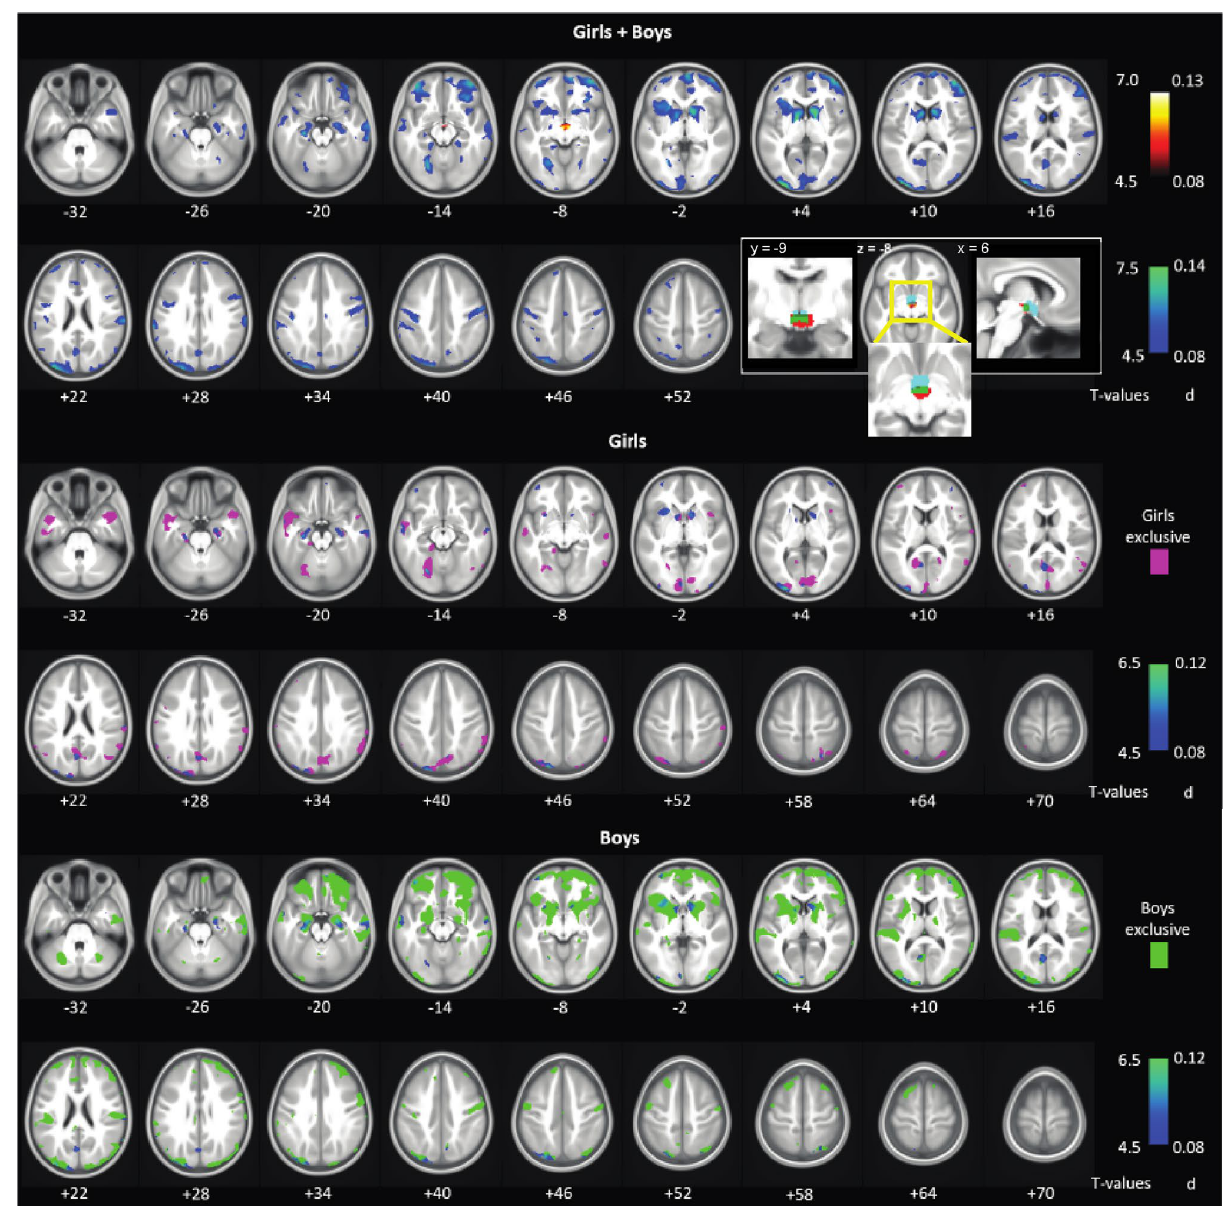
Figure 1. GMV correlates of ADHD scores for girls and boys combined (top panels), and for girls (middle) and boys (bottom), separately. Whole-brain regression, p < 0.05, FWE corrected. Color bars show voxel T values (left, cool colors to indicate negative correlation) and the corresponding effect sizes (right, Cohen’s d ). A single cluster in the area of the hypothalamus showed a positive correlation with ADHD scores in girls and boys combined; the inset shows the cluster overlaid on a hypothalamus mask (cyan) with overlapping voxels highlighted in dark green. For the clusters identified of girls and boys separately, we used exclusive masking to highlight those that appeared specific to girls (pink) and to boys (light green). Overall, boys relative to girls showed more widespread and significant GMV reductions in relation to ADHD